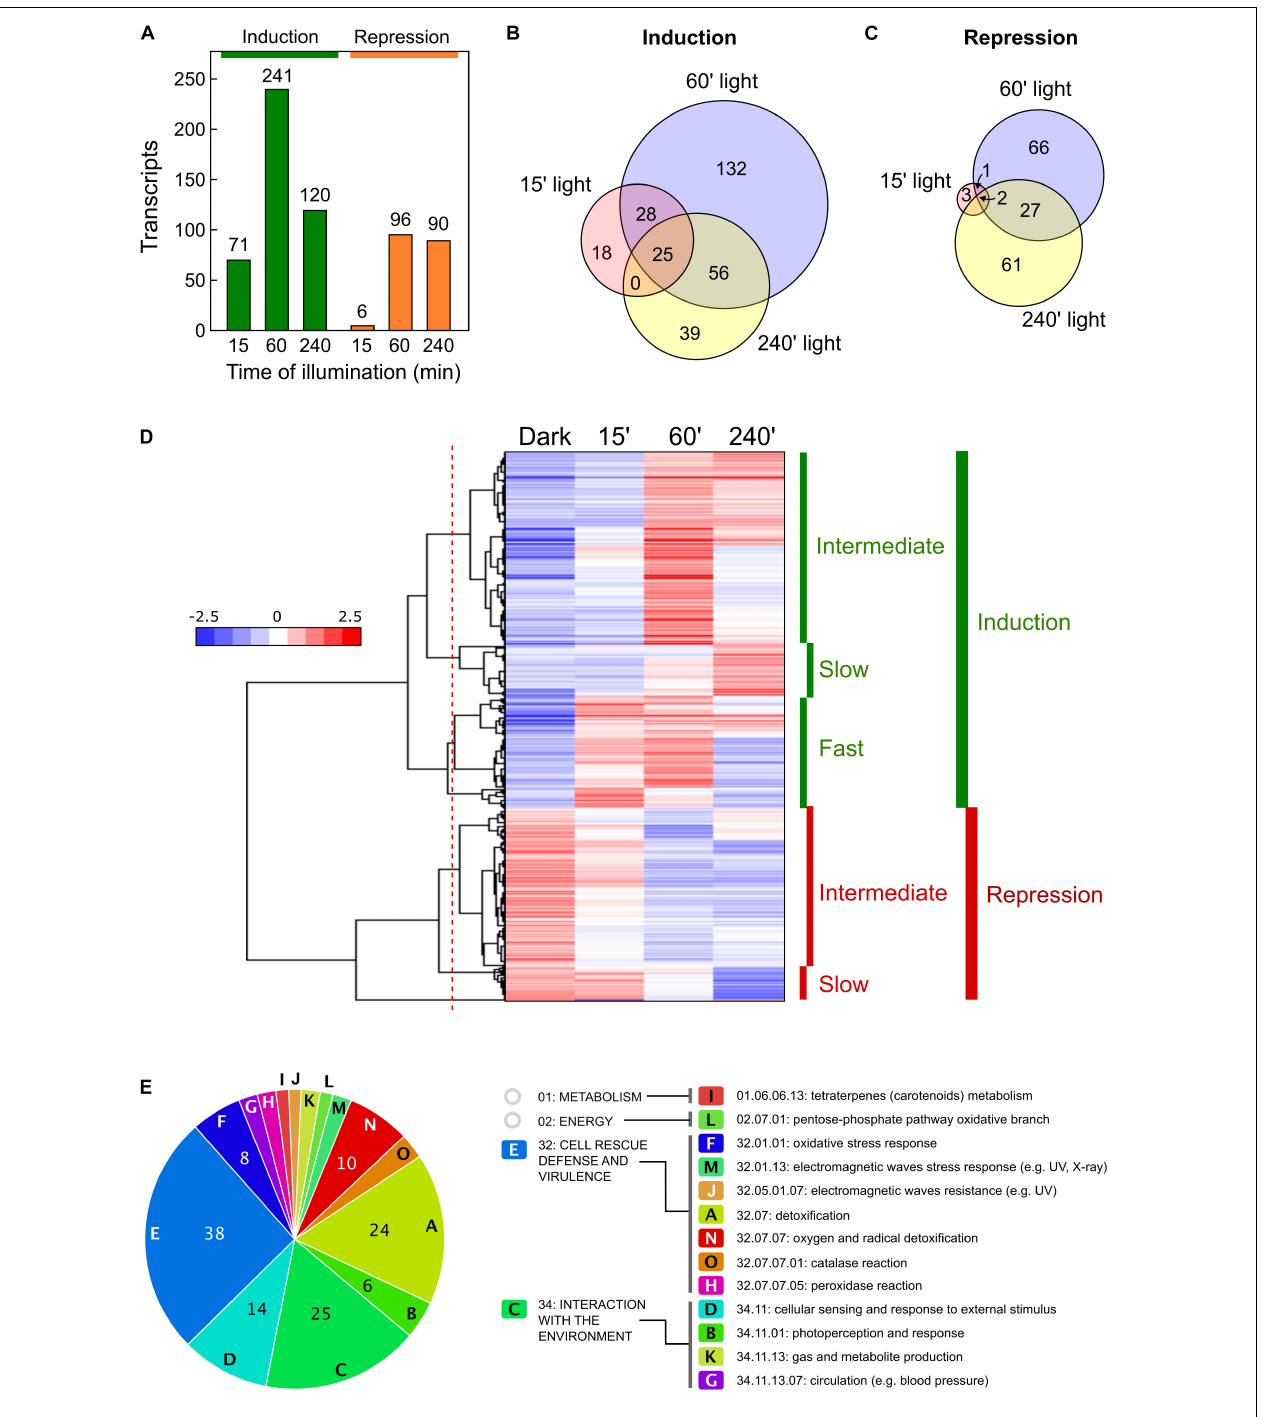
FIGURE 2 | Effect of illumination on the wild F. fujikuroi transcriptome. (A) Numbers of genes upregulated (green) or downregulated (orange) after 15-, 60-, or 240-min illumination. (B,C) Venn diagrams of the overlap between the genes induced (B) or repressed (C) after the illumination times indicated. (D) Hierarchical heatmap of the genes induced or repressed under the illumination times indicated. (E) Funcat categories of the genes induced after 60-min illumination.